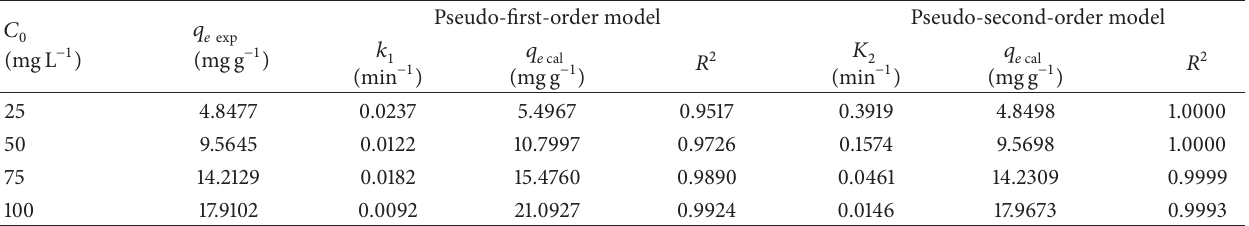
Table 2: Pseudo-first-order and pseudo-second-order rate constants at 35 ∘ C and different initial AB25 concentrations. Conditions: size of IJSP = < 53 𝜇 m; pH of AB25 soln = 5.44; dose of IJSP = 100 mg; and speed of agitation = 180rpm. Pseudo-first-order model